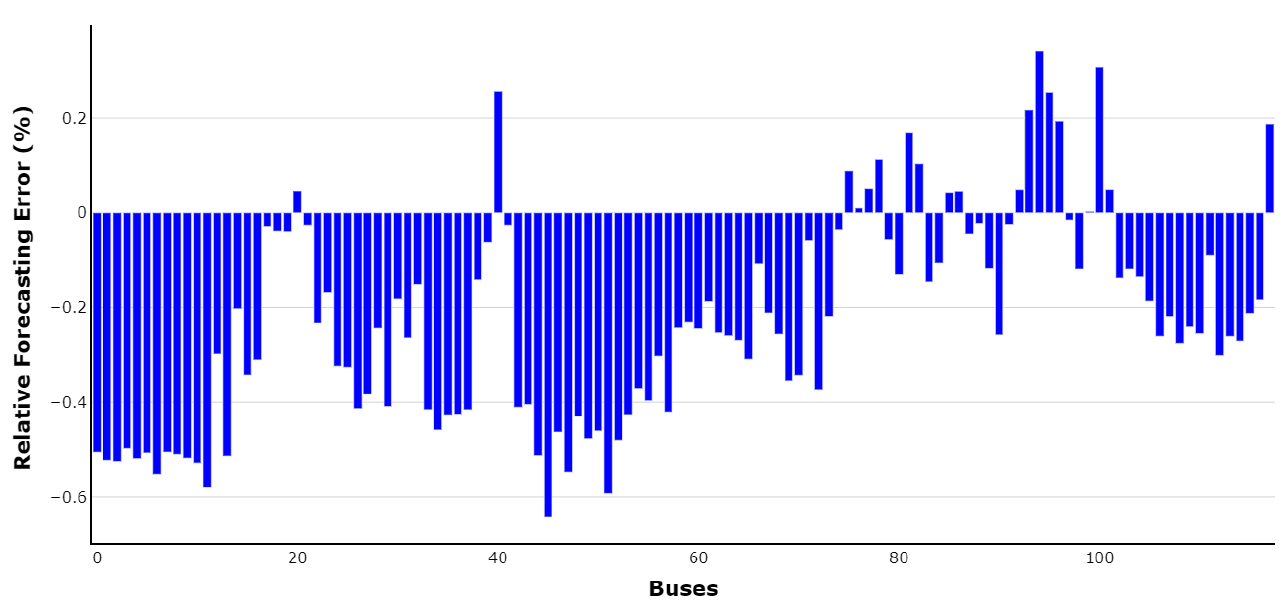
Figure 8. Relative forecasting error of a multi-output SVR regressor.